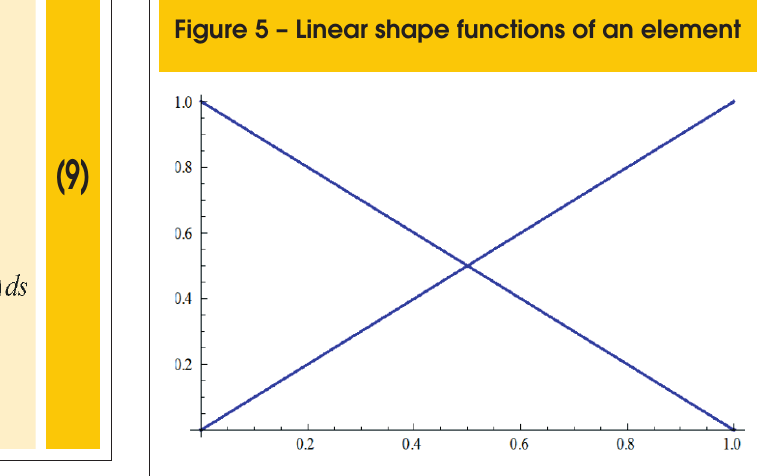
Figure 5 – Linear shape functions of an